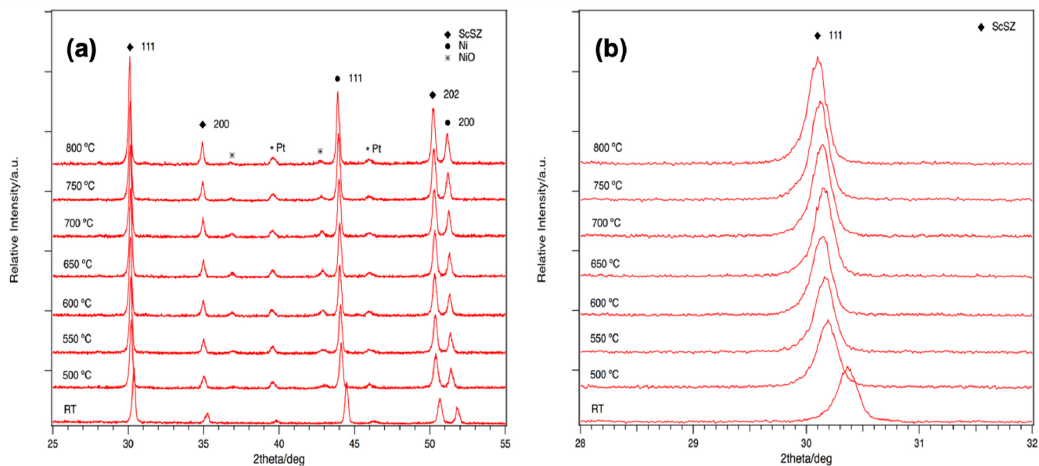
Figure 7. In-situ high temperature XRD stack patterns of the as-reduced Ni/ScSZ for a g/n ratio of 0.27, showing the structure at 500–800 °C intermediate temperatures. Appl. Sci. 2018 , 8 , x